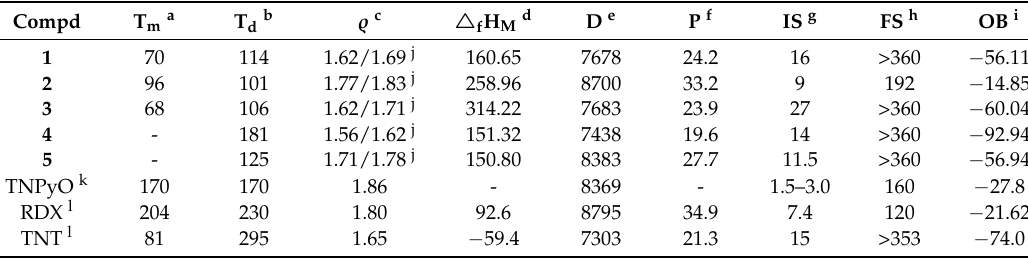
Table 2. Physical properties of trinitromethyl derivatives of